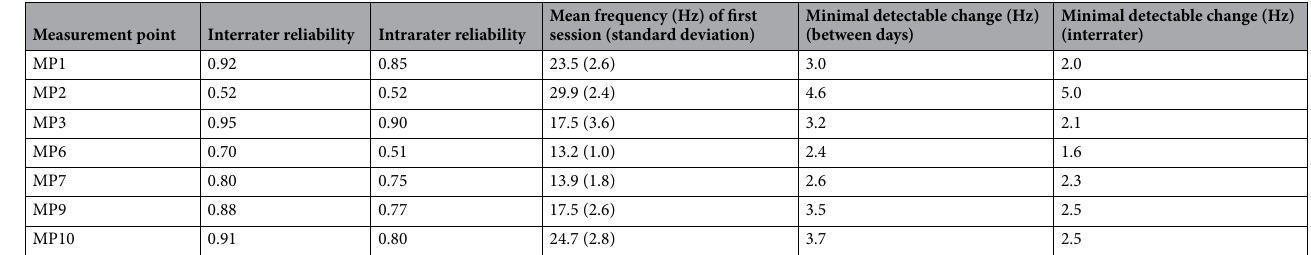
Table 2. Myoton frequency results for intrarater (between-days) and interrater reliability, mean frequency of first session and minimal detectable change. MP1 Plantar Fascia, MP2 Achilles tendon, MP3 Soleus, MP6 Splenius capitis, MP7 Anterior Deltoid, MP9 Patellar tendon, MP10 Anterior tibialis.